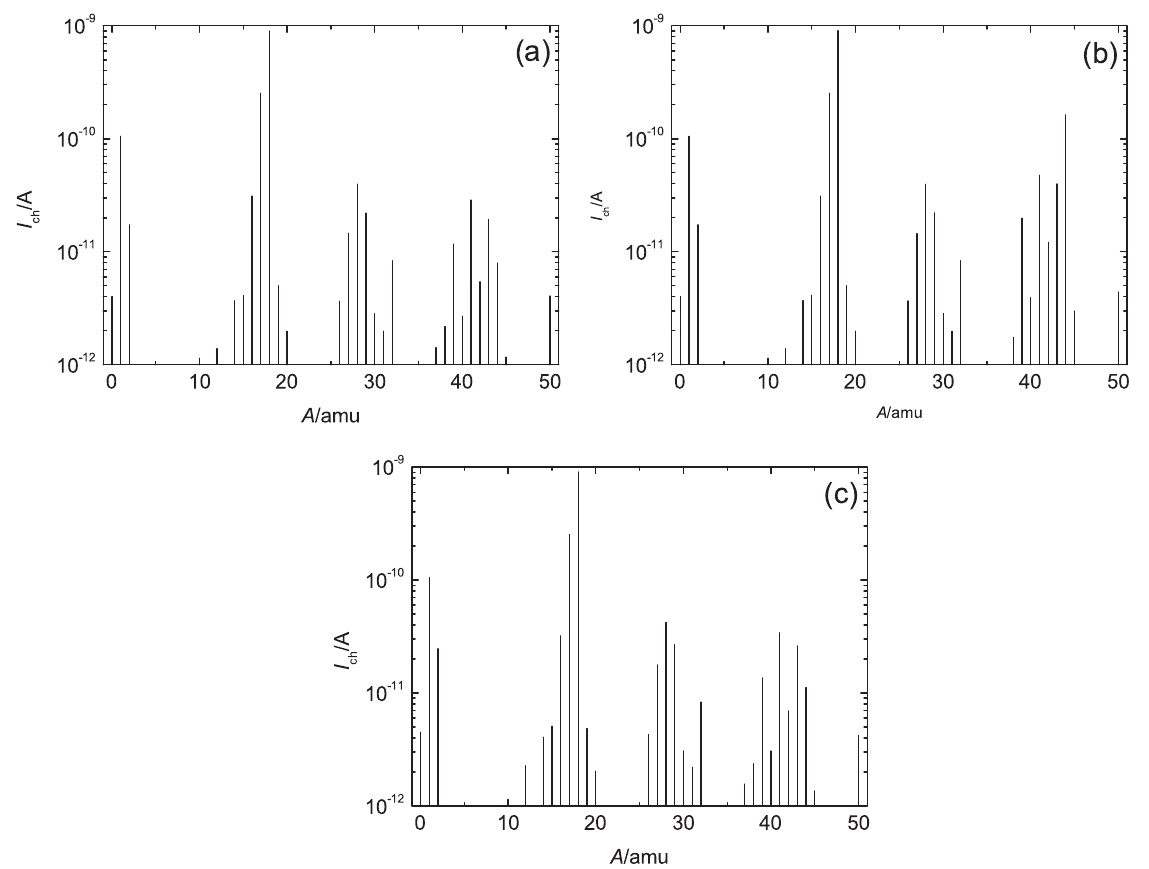
FIG. 8. OMSs of the CNT cathode: (a) before discharging, (b) on discharging, and (c) after discharging.